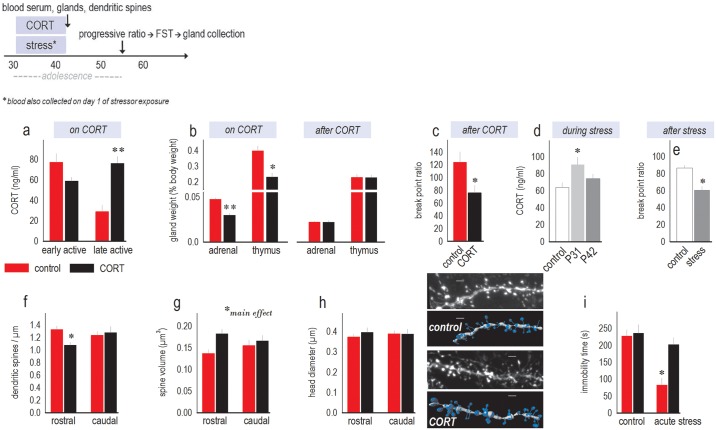
Effects of CORT exposure during adolescence: Validation of the procedure.Top: timeline of experimental events. See also Table 1. (a) Blood serum CORT levels at the end of an 11-d CORT exposure period (from P31–42) did not differ between groups at the beginning of the active cycle (following sleep) but were elevated in CORT-drinking mice (relative to control mice) at the end of the awake, active cycle. n = 5–10/group. (b) Adrenal and thymus gland weights also atrophied following exogenous CORT exposure (left), but glands recovered with a washout period (right). n = 5–6/group. (c) In a progressive ratio test, a history of CORT exposure reduced break point ratios. n = 5–6/group. (d) Forced swim stress in adolescence also increased blood serum CORT (though this effect appeared to habituate with repeated exposure). n = 5–11/group. (e) Further, break point ratios were also reduced, as with CORT exposure. n = 5–10/group. (f) CORT exposure from P31–42 also eliminated dendritic spines on excitatory neurons in the anterior mPFC (prelimbic subregion) of thy1-YFP expressing transgenic mice. n = 7 mice/group. (g) CORT increased overall spine volume. (h) Dendritic spine head diameter did not, however, change. Representative dendrites are adjacent (unprocessed image at top, followed by reconstruction). (i) Finally, in the forced swim test, a history of subchronic CORT exposure did not impact mobility but modified reactivity to an acute stressor: Acute stress induced mobility in control mice, but mice with a history of CORT exposure remained immobile. n = 5–7/group. * p ≤ 0.05, ** p < 0.001 compared to control (red or white bars). Scale bar = 2 μm. Raw data for this figure can be found in S1 Data. CORT, corticosterone; FST, forced swim test; mPFC, medial prefrontal cortex; P, postnatal day; YFP, yellow fluorescent protein.